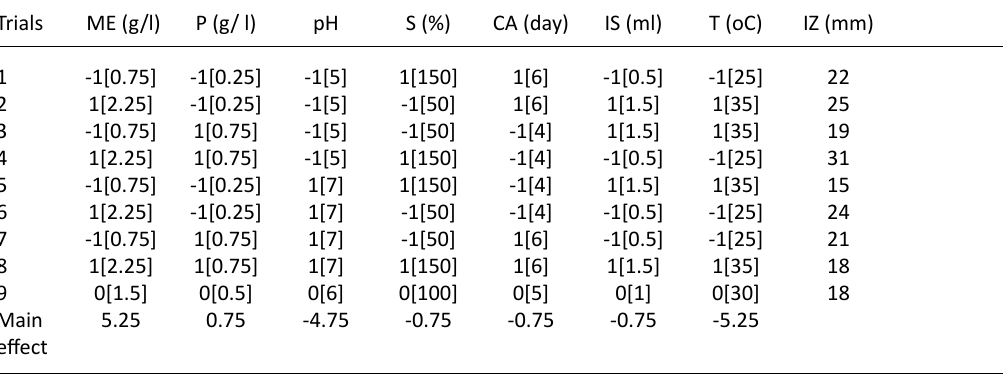
Table 3. Levels of independent factors and results of Plackett-Burman experimental design Trials